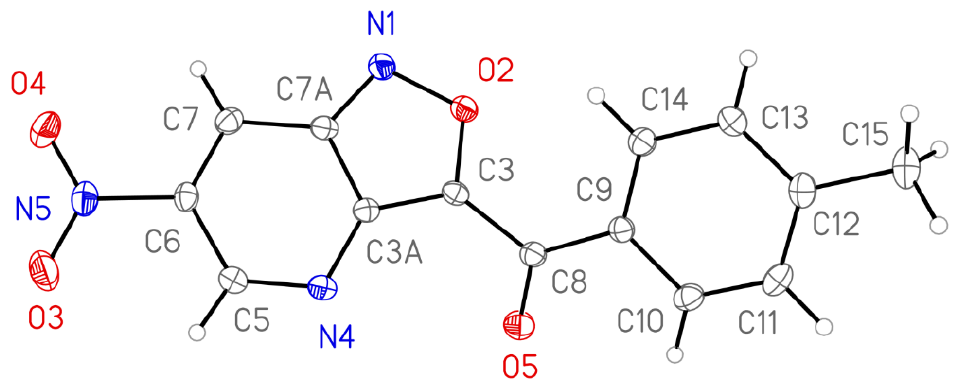
Figure 3. General view of 3b in crystal. Anisotropic displacement parameters for non-hydrogen atoms are drawn at 50% probability.